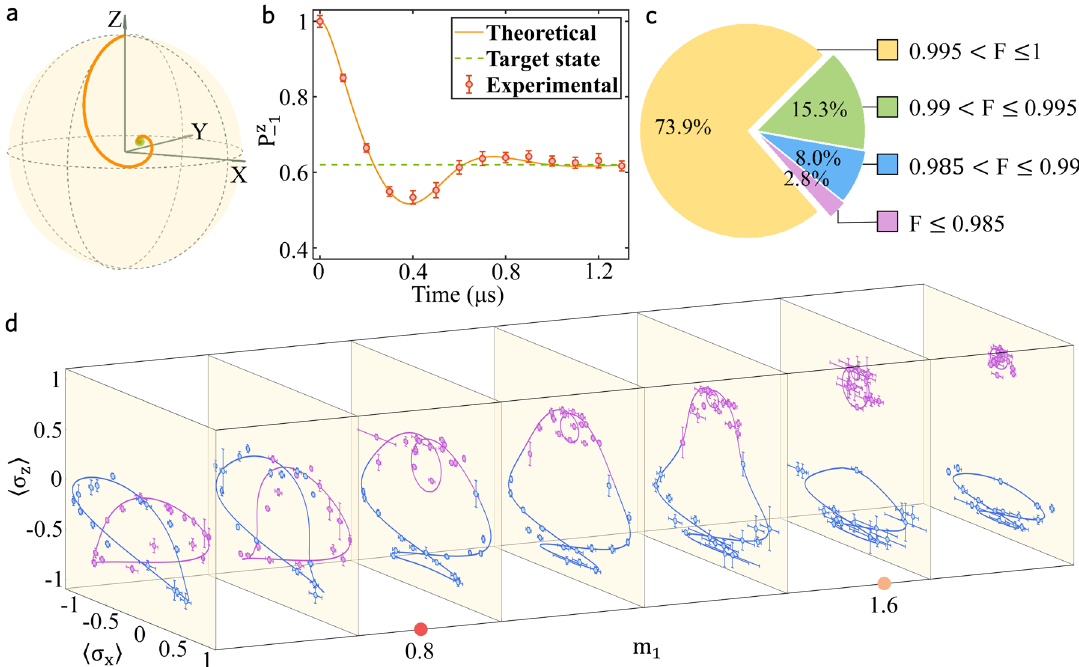
Fig. 2 State preparation through non-unitary dynamics and observation of knot structures for different phases. a Decaying trajectory of the electron spin state on the Bloch sphere under non-unitary dynamics. The green dot represents the target state. b Non-unitary time evolution of the electron spin population P z ¼ Tr ð ρ e (cid:3) 1 j i e (cid:3) 1 h jÞ . The red dots with error bars are the experimental results. Error bars are (cid:3) 1 obtained via Monte Carlo simulation by assuming a Poisson distribution of the photon counts for 10,000 times. The orange solid line shows the theoretical curve predicted by numerical simulation. The green dashed line indicates the ideal population of the target state assuming in fi nite evolution time. For a , b the underlying Hamiltonian is − H ( k ) with the parameters m 1 = 0.9855, m 2 = 0.6, and k = 0.125 π . c Pie chart illustrates the percentage distribution for the fi delity (denoted as F) of the 1184 experimentally prepared eigenstates f R 1 j i ; R 2 j ig with varying k (see Supplementary Fig. 6). d Experimental results for 〈 σ 〉 versus 〈 σ 〉 as k sweeping the fi rst Brillouin zone with different values m z x 1 and of m 1 , where the blue and purple parts denote the average values of σ x , z with respect to R 1 j i and R 2 j i , respectively. The dots with error bars represent the experimental data, whereas the solid lines denote the theoretical predictions. The red and orange dots denote the phase transition values of m 1 , while fi xing m 2 =